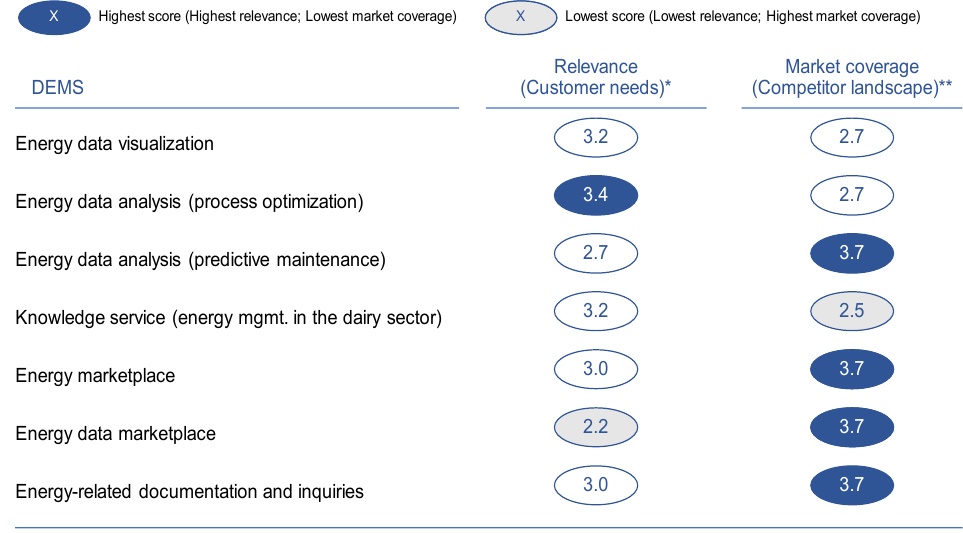
Figure 6. Market opportunity for DEMS considering customer needs and market coverage.